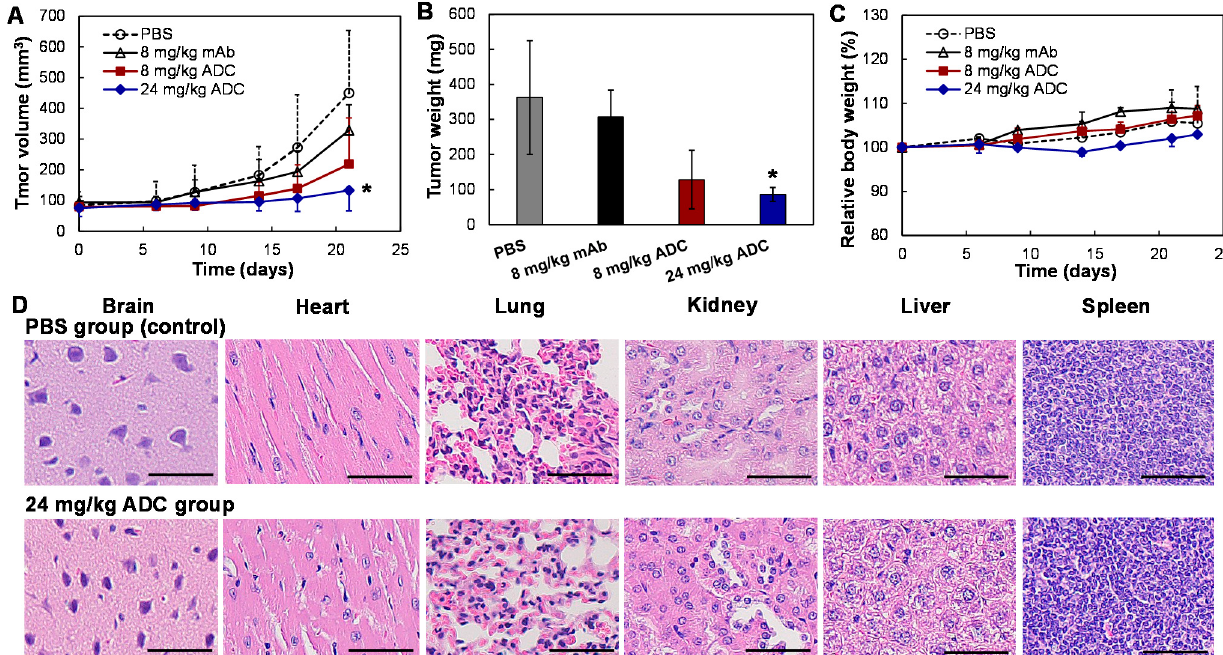
Figure 6. In vivo anti-tumor efficacy study of ADC in the TNBC (MDA-MB-231-FLuc) xenografted NSG mouse models. ( A ) Tumor volume changes with ADC treatment (data represent mean ± SEM, n = 5). PBS, mAb, or ADC were i.v. administrated into xenograft models on Days 6, 10, 14, and 18. Tumor size was measured with a caliper. Tumor volumes between the four groups were analyzed with mixed design ANOVA and multiple comparison. * p < 0.005. ( B ) Wet weight of the tumors excised from euthanized mice. * p ≤ 0.005. ( C ) Body weight changes. ○ : PBS, ∆ : 8 mg/kg mAb, ■ : 8 mg/kg ADC, and ♦ : 24 mg/kg ADC. ( D ) H&E staining of main organs, including brain, heart, lung, kidney, liver, and spleen. Scale bar equals to 50 µm.